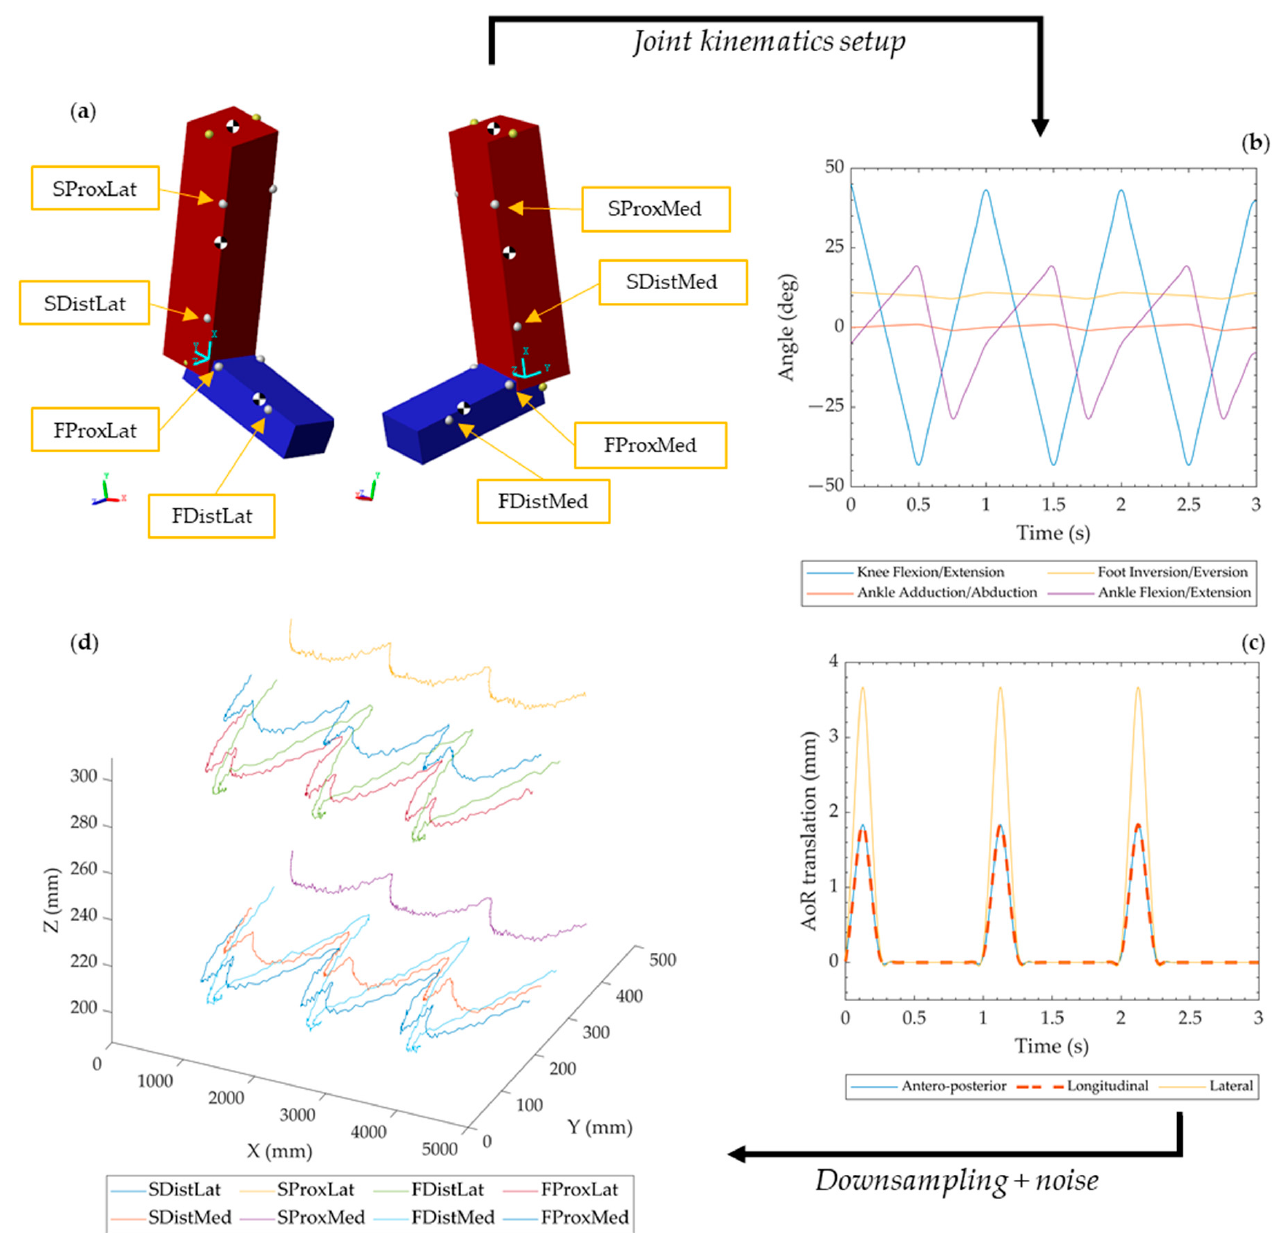
Figure 1. The methodology for the generation of noisy marker trajectories: ( a ) two views of the multi-body model, with markers on the shank (red) and foot (blue) highlighted, as well as the joint reference frame at the ankle (cyan); ( b ) the angular motion of the knee and ankle joints; ( c ) the linear motion of the ankle AoR; ( d ) downsampled and noisy marker trajectories in the global coordinate system. The plots refer to a generic tri-planar (6 DoFs) motion configuration.